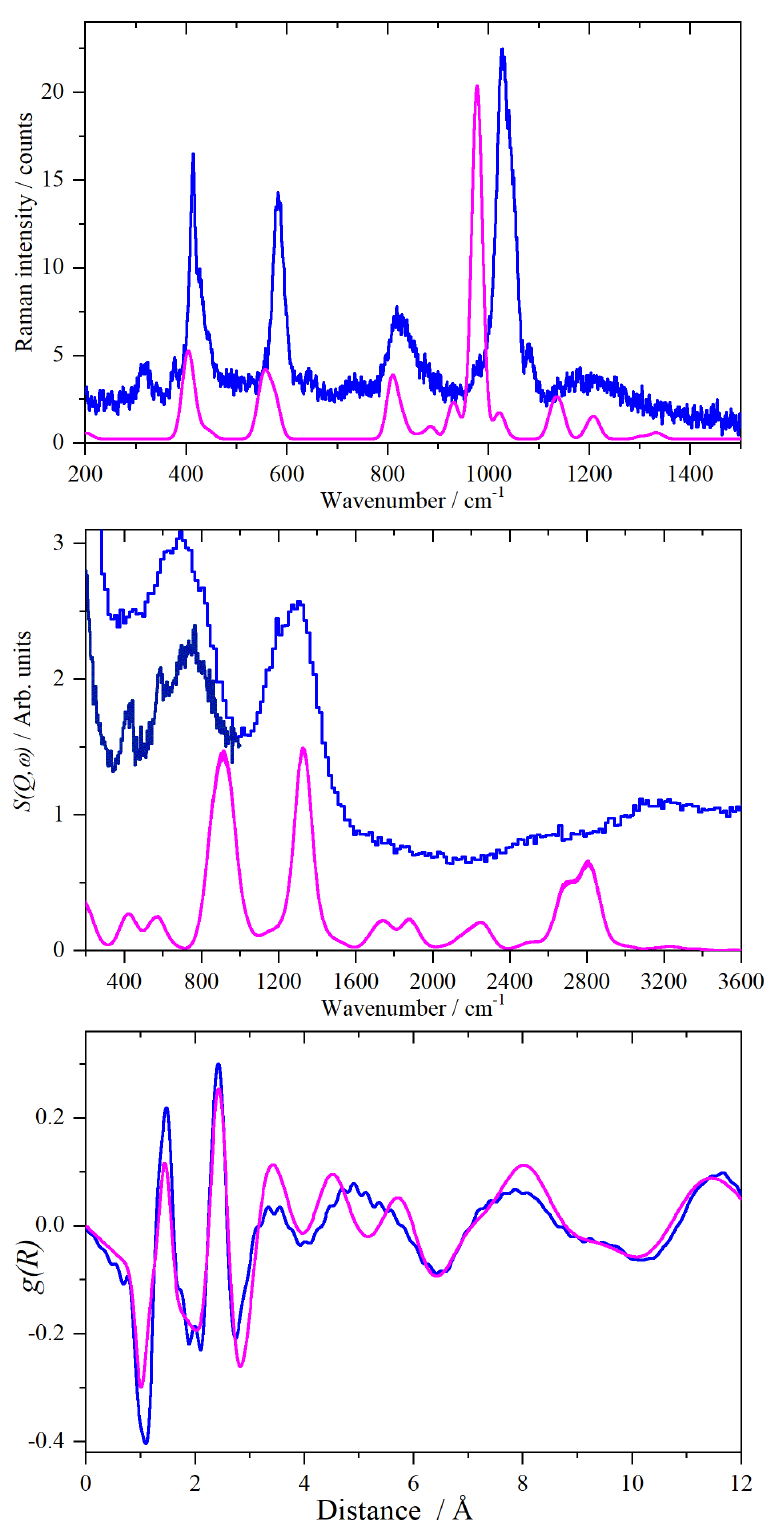
Figure 9. Comparison of experimental (blue) and the calculated (magenta, generated from the structure shown in the right-hand side of Figure 8) data of CsHSO 4 in phase I at 430 K. Bottom: radial distribution function, g(R) . Middle: INS spectrum (experimental MAPS spectra recorded with 650 meV and 150 meV (navy) incident energy). Top: Raman spectra.